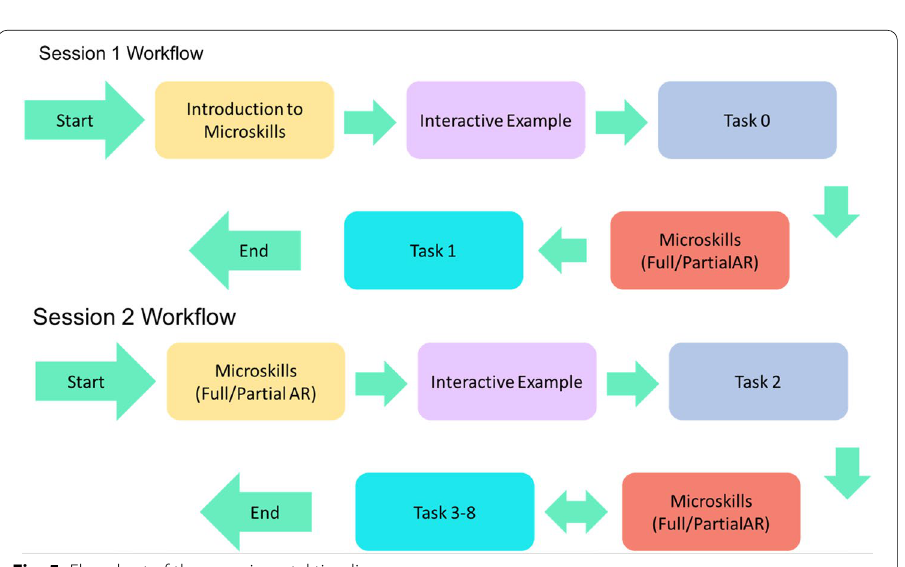
Fig. 5 Flowchart of the experimental